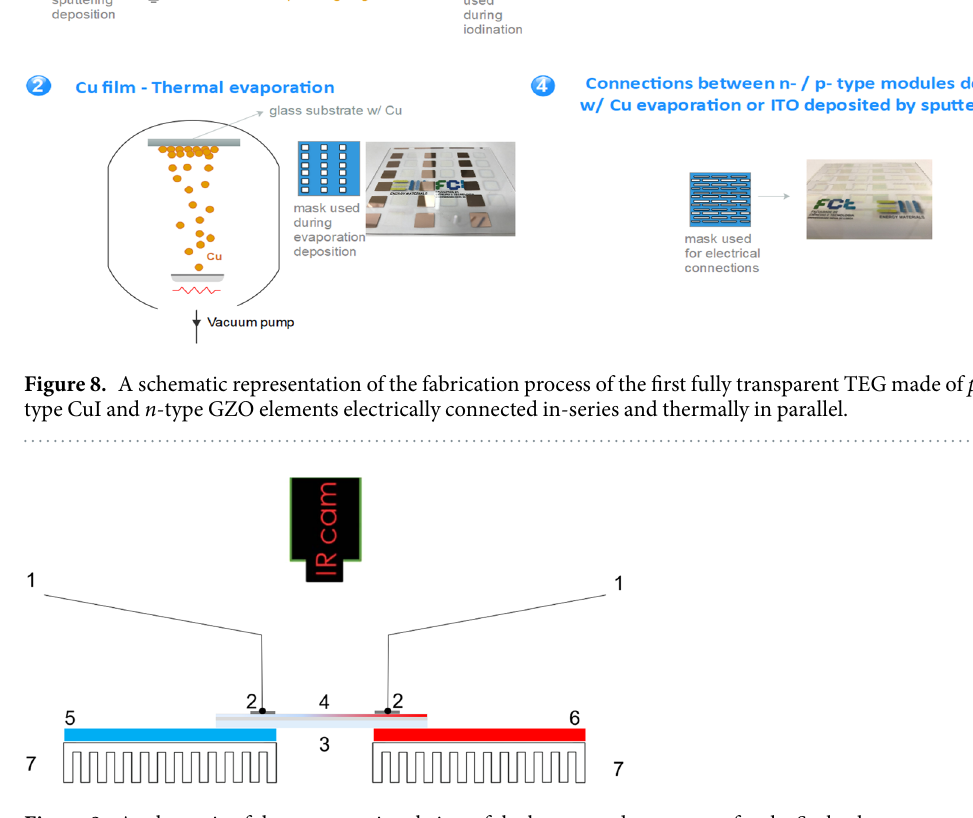
Figure 9. A schematic of the cross-sectional view of the home-made apparatus for the Seebeck measurements of thin films. (1) Nano-voltmeter probes; (2) Contacts on thin film; (3) Glass substrate; (4) Thermoelectric thin film; (5) Cold Peltier; (6); Hot Peltier; and (7)